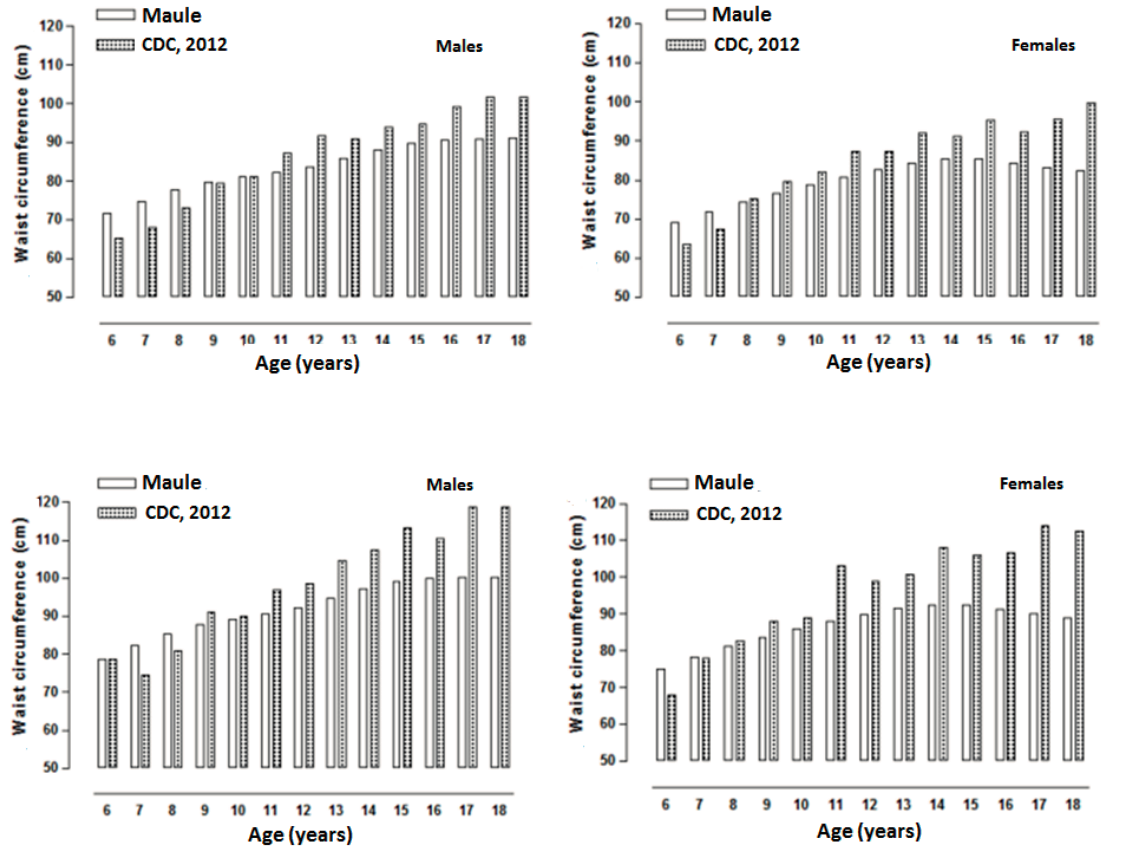
Figure 3. Graphic comparison of percentiles p85 (above) and p95 (below) of the CDC-2012 and the curve of children and adolescents of both sexes from the Maule